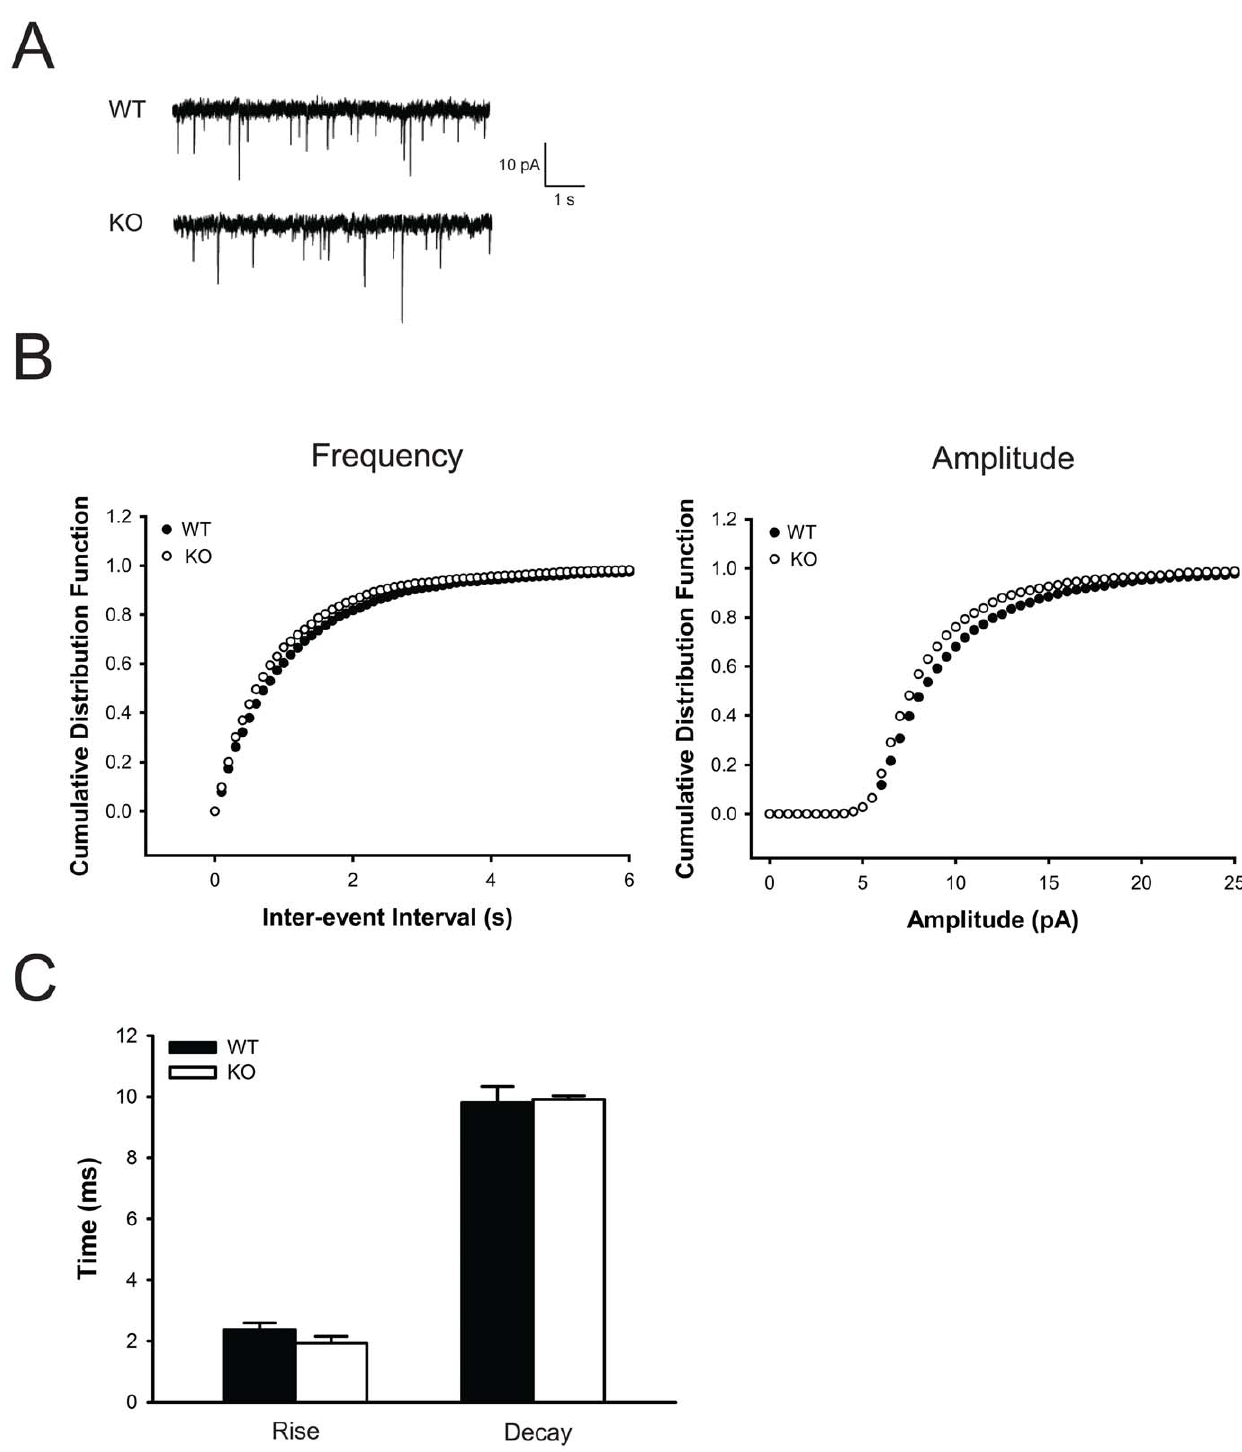
Figure 4. Hippocampal CA1 electrophysiological whole-cell recordings. ( A ) Representative traces of mEPSC recording from WT and Btbd9 mutant mice. ( B ) Btbd9 mutant mice showed a decrease in both frequency and amplitude of mEPSC events compared to WT mice (p , 0.01 each). ( C ) Btbd9 mutant mice showed no difference from WT in rise and decay times of mEPSC events. Bars represent means 6 SEM. doi:10.1371/journal.pone.0035518.g004 impulse to evoke the further release of synaptic vesicles from the have been associated with an inverse probability of synaptic vesicle pre-synaptic terminal. PPRs are on the order of milliseconds and release, where increases in PPRs are indicative of a decreased seconds and therefore a measure of short-term plasticity. PPRs probability of synaptic vesicle release and vice versa. We therefore